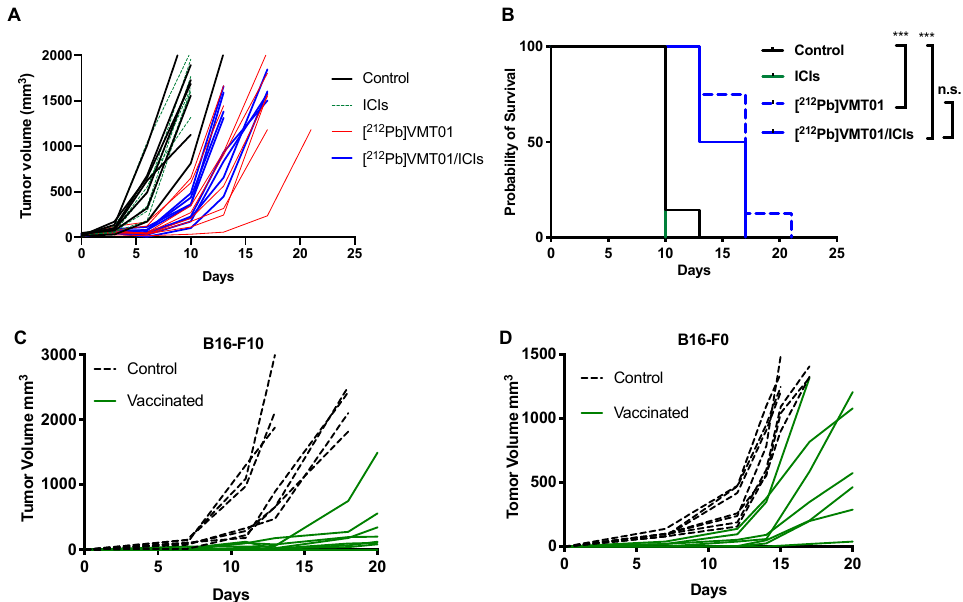
Figure 4. [ 212 Pb]VMT01 α -TRT induces anti-tumor immune responses that rely on adaptive immunity. ( A ) individual tumor volume in RAG1 K/O mice after treatments of rat IgG isotype control (con ‐